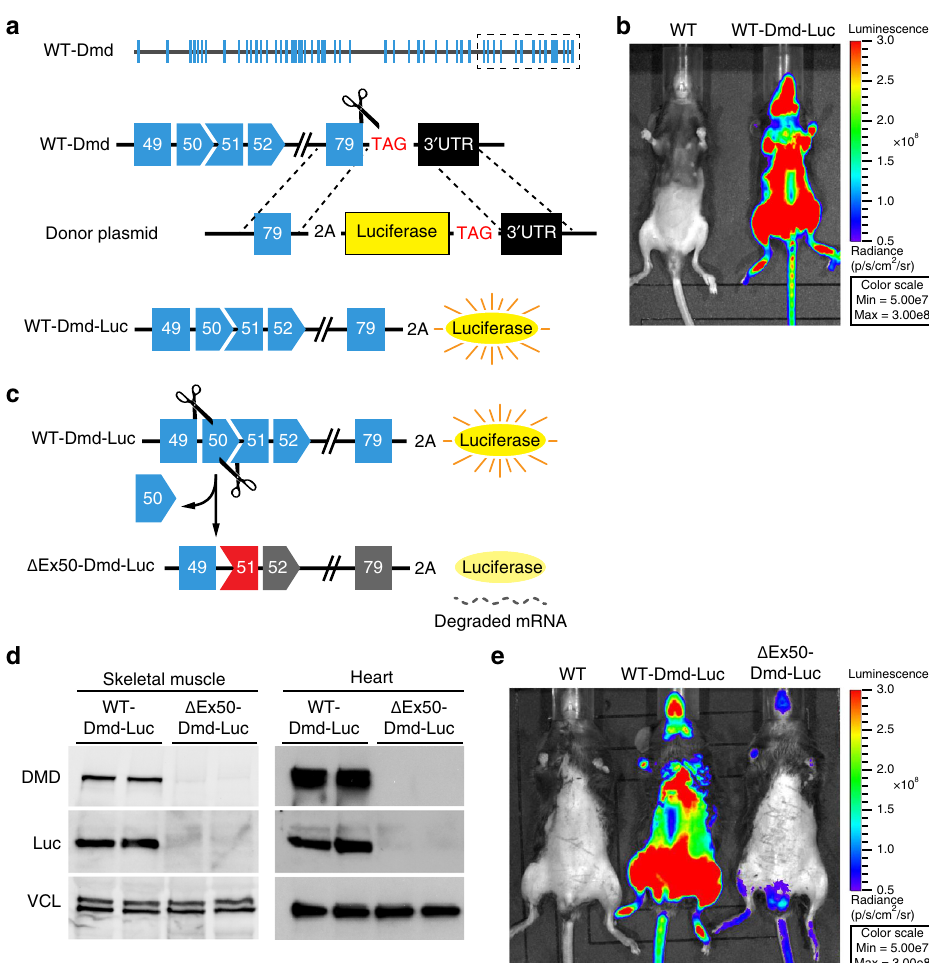
Fig. 1 Δ Ex50-Dmd-Luc mouse model. a Strategy for creation of dystrophin reporter mice. Dystrophin ( Dmd ) gene with exons is indicated in blue. Using CRISPR/Cas9 mutagenesis, we inserted a DNA cassette encoding the luciferase reporter with the protease 2A cleavage site at the 3 ′ end of the dystrophin coding region. b Bioluminescence imaging of wild-type (WT) and Dmd knock-in luciferase reporter (referred as WT-Dmd-Luc) mice. c Strategy for creation of Δ Ex50-Dmd-Luc reporter mice. Dystrophin ( Dmd ) gene with exons is indicated in blue. Using CRISPR/Cas9 mutagenesis, we deleted the exon 50 of Dmd gene. d Western blot analysis of dystrophin (DMD), luciferase and vinculin (VCL) expression in skeletal muscle and heart tissues. e Bioluminescence imaging of wild-type (WT), WT-Dmd-Luc and Δ Ex50-Dmd-Luc reporter